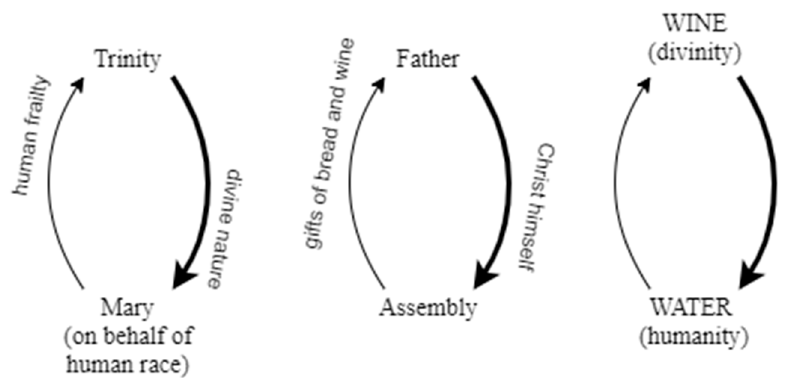
Figure 1. The “wonderful exchange” of incarnation and liturgy: ( a ) the Incarnation described in the Sacrum commercium antiphon; ( b ) the liturgical exchange of the Eucharist; ( c ) the water and wine mixing as a symbol of incarnation and liturgical exchange.